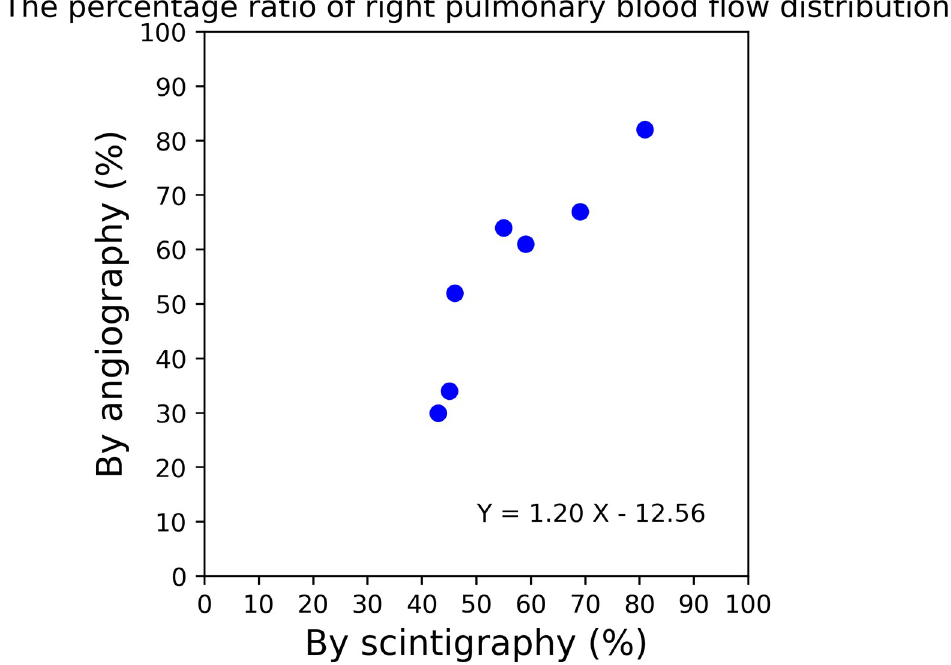
Fig 7. Comparison of the right-to-left ratios between X-ray pulmonary angiography (XA) and lung perfusion scintigraphy (LS). The values on each axis are the percentages of right pulmonary blood flow distribution relative to the total pulmonary blood flow. The percentage of right pulmonary blood flow calculated by angiography was in good agreement with that calculated by lung scintigraphy, with a slope of 1.2 and a Pearson correlation coefficient of 0.91 (p <